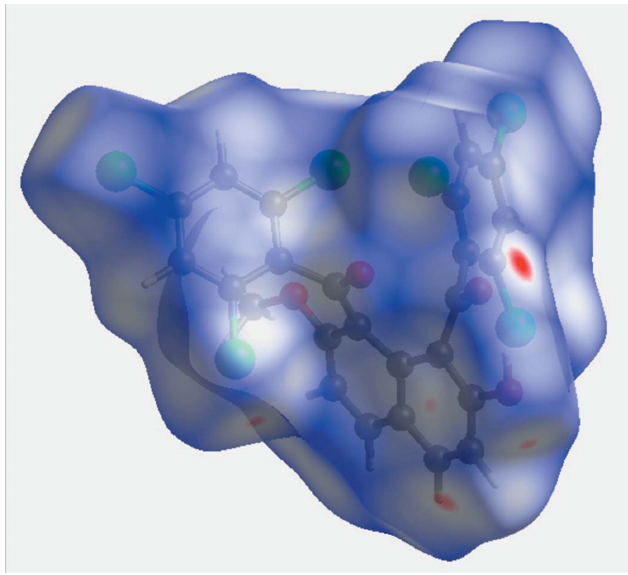
Figure 4 The Hirshfeld surface of the title compound mapped over d norm , in the range (cid:5) 0.0895 to 1.1549 a.u.